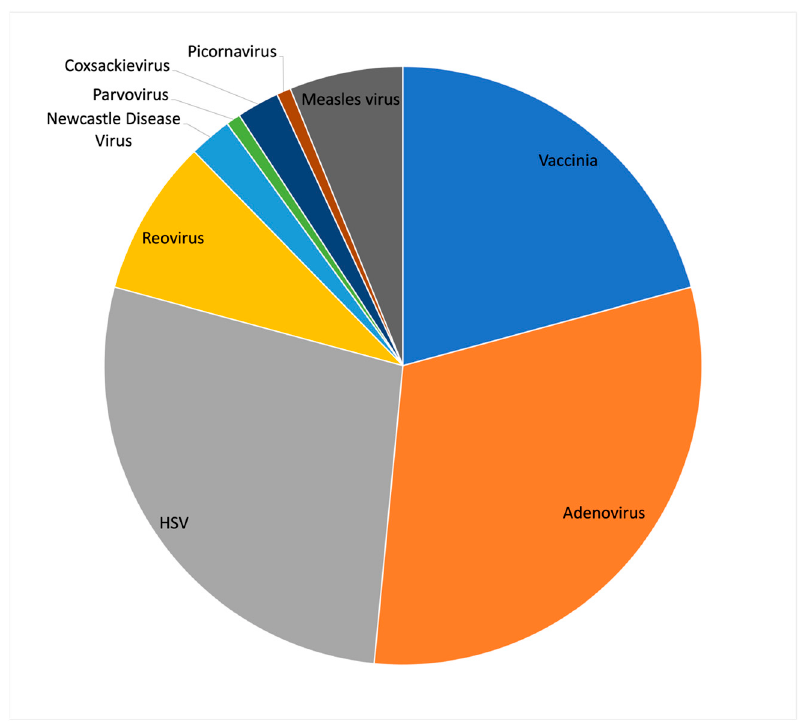
Figure 1. Summary of virus types currently in clinical trials as oncolytic agents. (Data source: clinicaltrials.gov, accessed on 1 October 2022).